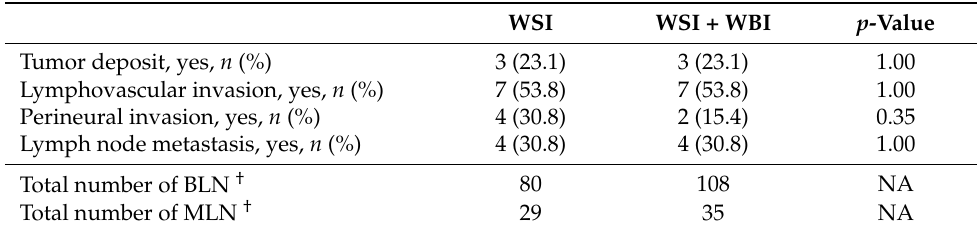
Table 2. Pathological review comparison between conventional whole-slide imaging and combination of whole-slide with whole-block imaging. WSI WSI + WBI p -Value Tumor deposit, yes, n (%) 3 (23.1) Lymphovascular invasion, yes, n (%)